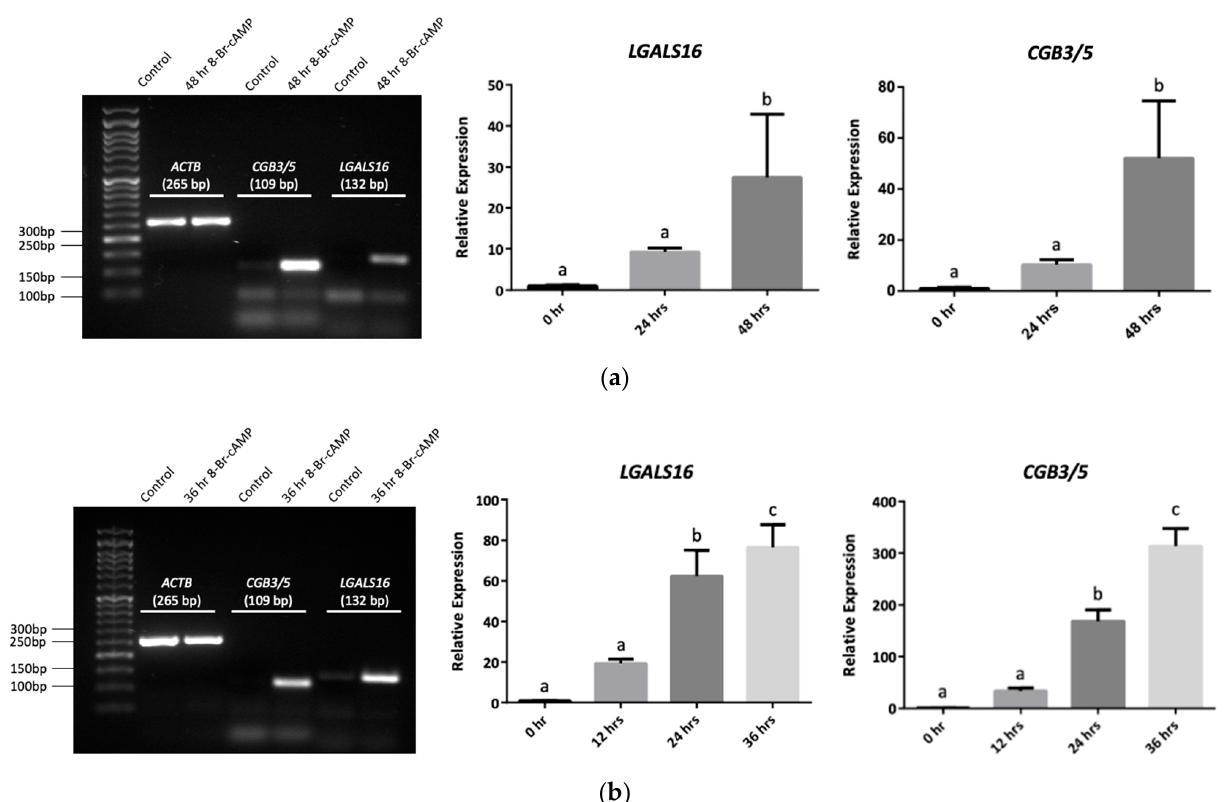
Figure 4. LGALS16 expression in human placental choriocarcinoma cell lines, BeWo and JEG-3. Cells were treated with 8-Br-cAMP (250 µ M) for different periods of time to induce syncytiotrophoblast differentiation. ( a ) BeWo cells ( n = 4); ( b ) JEG-3 cells ( n = 3). Agarose gels on the left confirm the expected size of PCR amplicons. Bar graphs show the fold changes in the expression of LGALS16 and CGB3/5 genes obtained by qPCR, which were quantified by the Livak method (2 − ∆∆ CT ) using ACTB as a reference gene. Data are presented as means ± SD; means with the same letter are not significantly different from each other (Tukey’s post hoc HSD test, p >